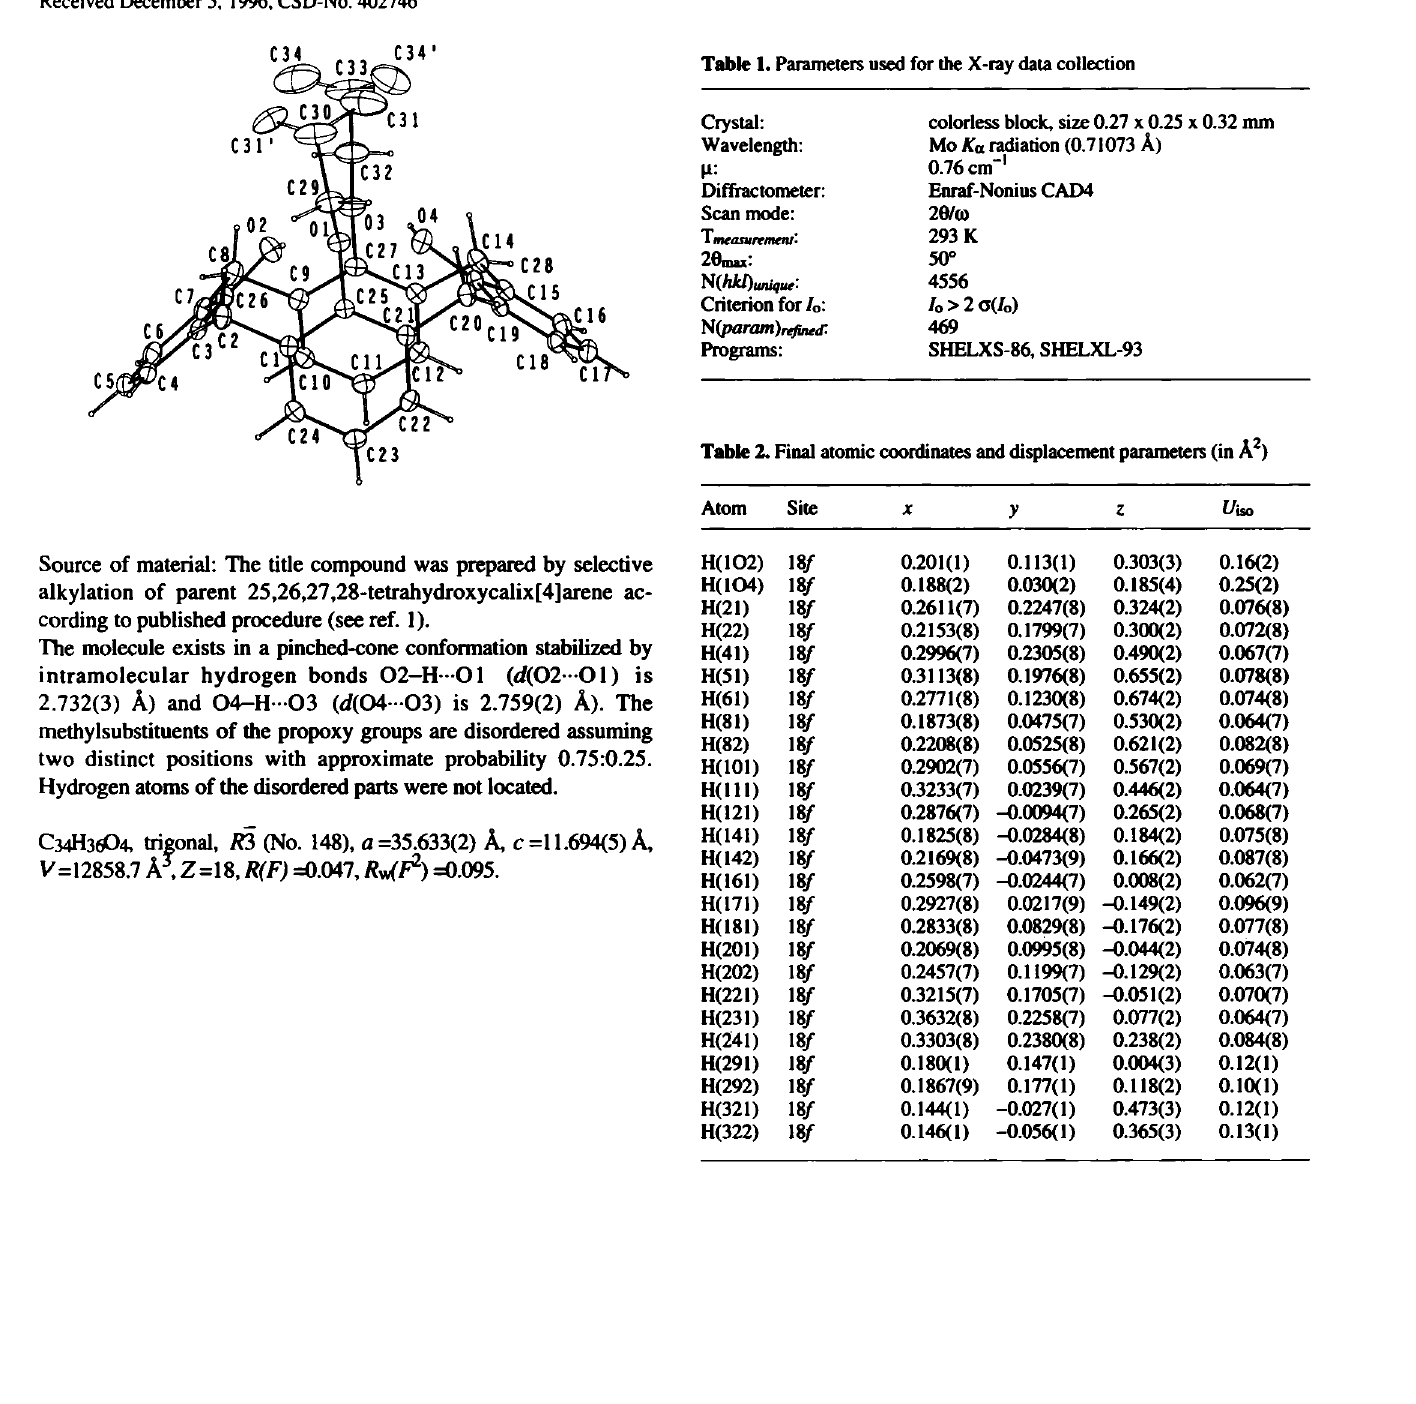
Table 1. Parameters used for the X-ray data collection